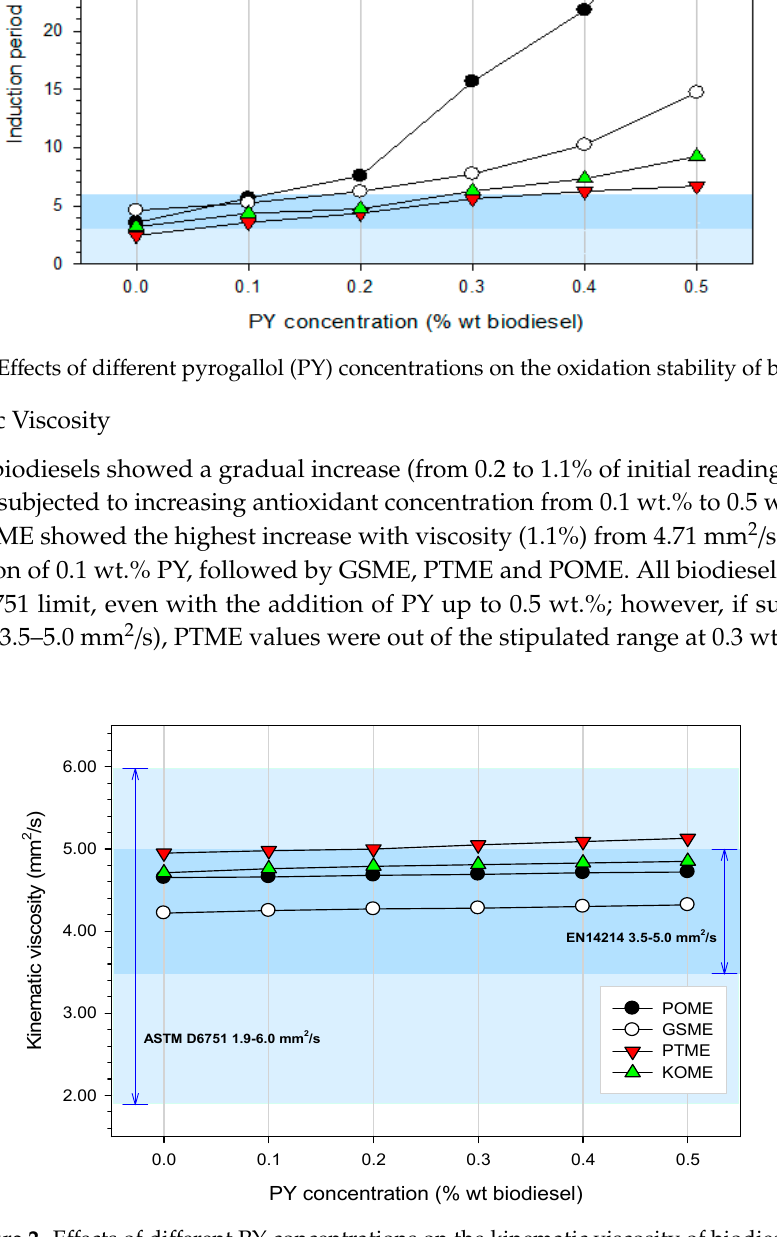
Table 5. ASTM D7467 requirements for diesel blends B6-B20.